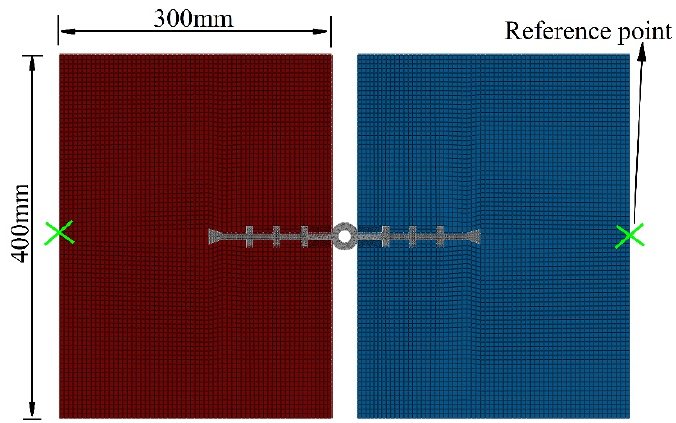
Figure 9. Finite element analysis model.